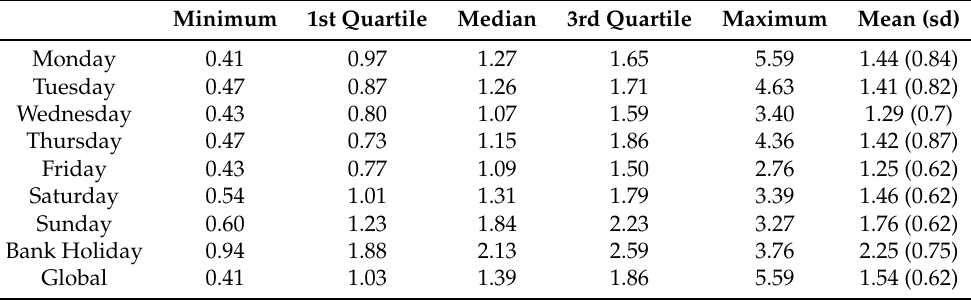
Table 17. Daily MAPE (in %) for FSSM model (11) on RTE load demand data.